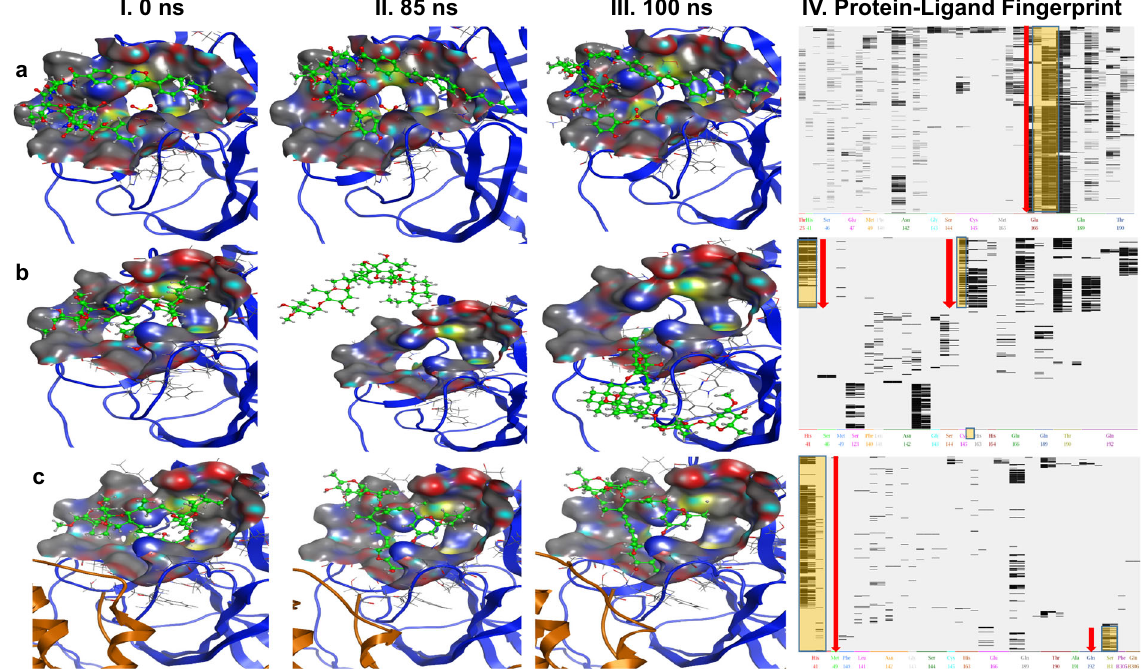
Fig. 7 MD 100 ns simulation studies for ivermectin and micafungin. MD simulation studies were carried as described under Methods section. Interaction of micafungin ( a ), and ivermectin ( b ) with monomeric form of 3 CLpro enzyme. c Interaction of ivermectin with active site of 3CLpro homodimer. Panel I – III represents the interaction of ligand at different time points in nano second (ns). Panel-IV represents the ligand-binding fi ngerprint of micafungin and ivermectin with speci fi c amino acids of 3CLpro